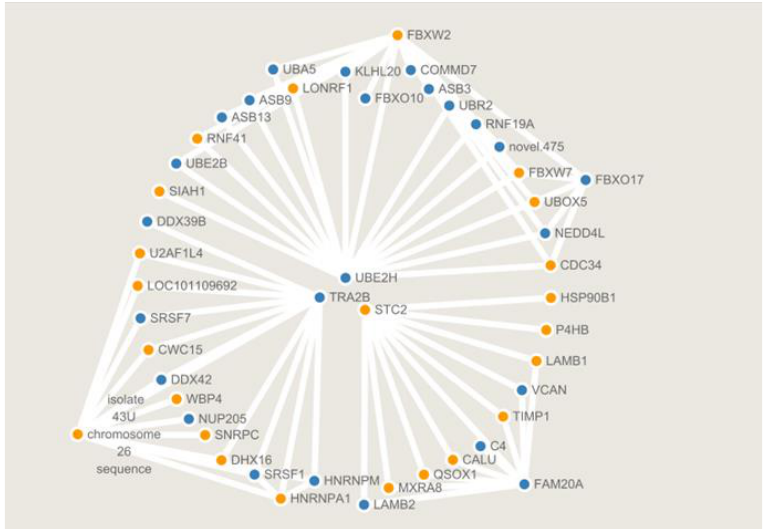
Figure 10. Interaction relationship between functionally related genes and target genes. Each node represents a different gene. Orange nodes represent the upregulation of the gene and blue nodes represent the downregulation of the gene. The line represents the existing interaction relationship. It can be seen intuitively from the figure that genes such as UBE2H, TRA2B, STC2, FBXO17, and FBXW2 have critical regulatory functions in this interaction network.